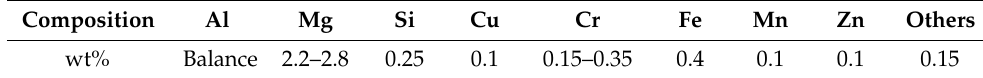
Table 1. The composition of aluminum 5052